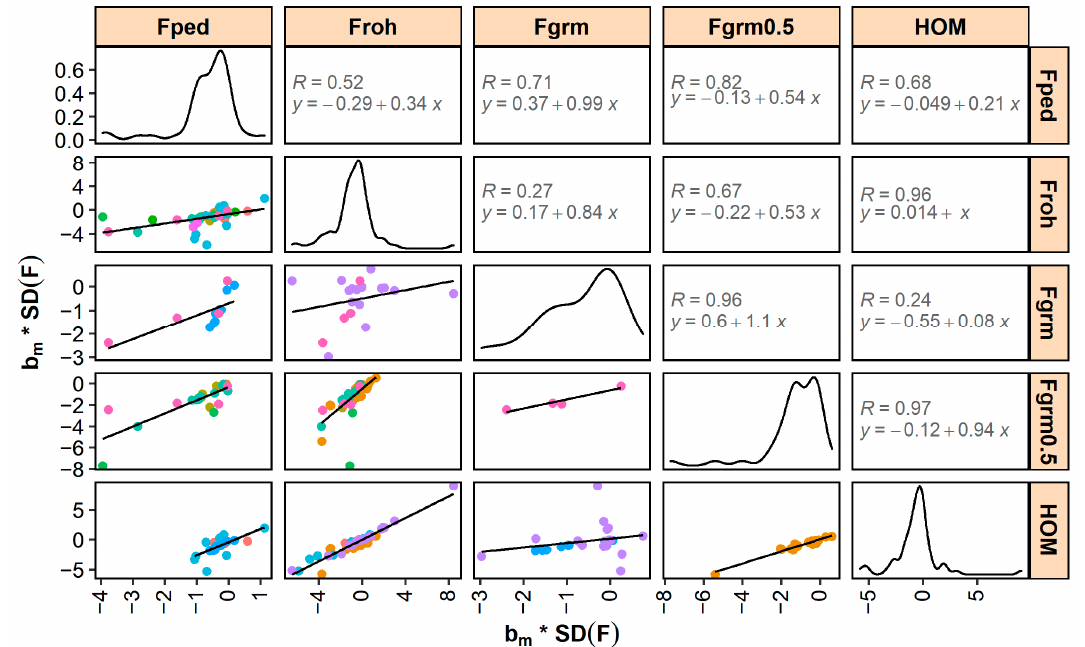
Figure 3. Relationship between inbreeding depression estimates expressed as percentage of a trait’s mean per 1 standard deviation increase in inbreeding ( b m * SD(F)) across different measures of inbreeding. The data points (colored per study) and linear trendline are shown (lower triangle) as well as the density curve for each inbreeding measure (diagonal) and the correlation and regression equation (upper triangle). Note that slopes of the linear trendline differ from 1, which is also expected when correlations between inbreeding measures themselves are not equal to 1. F PED = pedigree inbreeding; F ROH = inbreeding based on runs of homozygosity; F GRM = inbreeding from genomic relationship matrix (studies in pink and purple used VanRaden’s method 2, and light blue Yang’s method); F GRM 0.5 = inbreeding from genomic relationship matrix with allele frequencies fixed to 0.5; HOM = percentage of homozygous